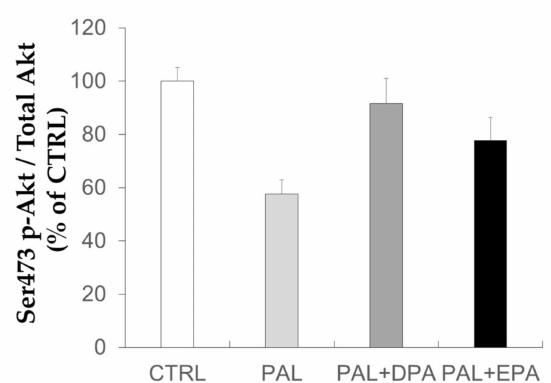
Figure 2. Effects of palmitic acid and LCn-3PUFA on insulin signaling in skeletal muscle cells. C2C12 muscle cells were treated with 500 µ M palmitic acid (PAL) with or without 10 µ M docosapentaenoic acid (DPA) or 50 µ M eicosapentaenoic acid (EPA). Before harvesting, cells were stimulated with insulin (100 nM) to evaluate insulin sensitivity by the quantification of Akt protein phosphorylation. Data are